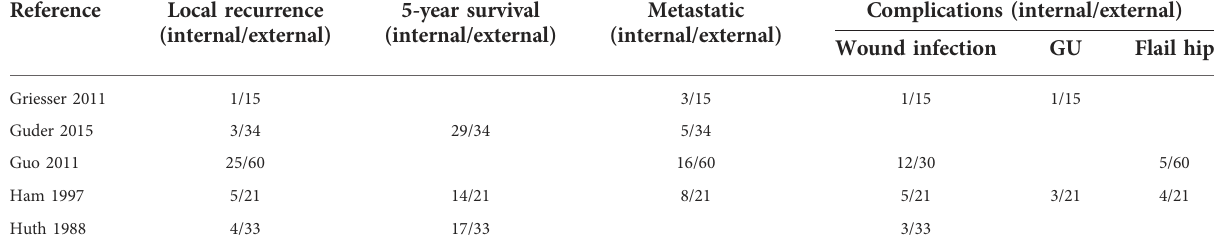
TABLE 2 Outcomes of the included